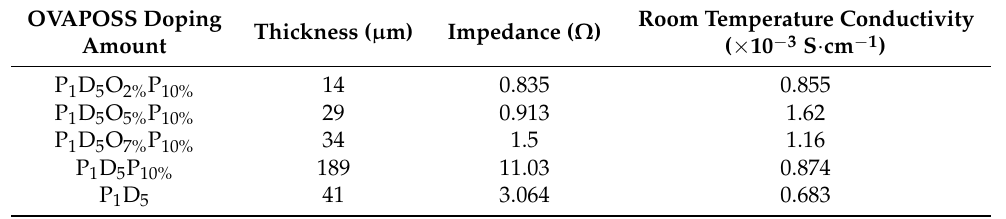
Table 1. Room temperature impedance and conductivity of polymer membranes with different OVAPOSS doping